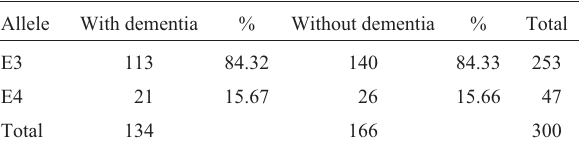
Table 2 - ApoE allele frequencies in elderly Saudi subjects with and without dementia.